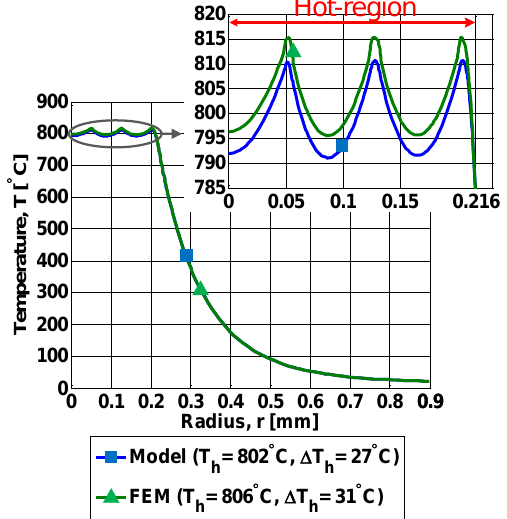
Figure 6. Temperature distribution in the micro-hotplate; T is the average temperature in h the hot-region and Δ T is maximum temperature difference in the hot region; at the edge of h the hot region (which extends up to 0.216 mm), there is a sharp decrease of the temperature which is responsible for the larger values of Δ T h